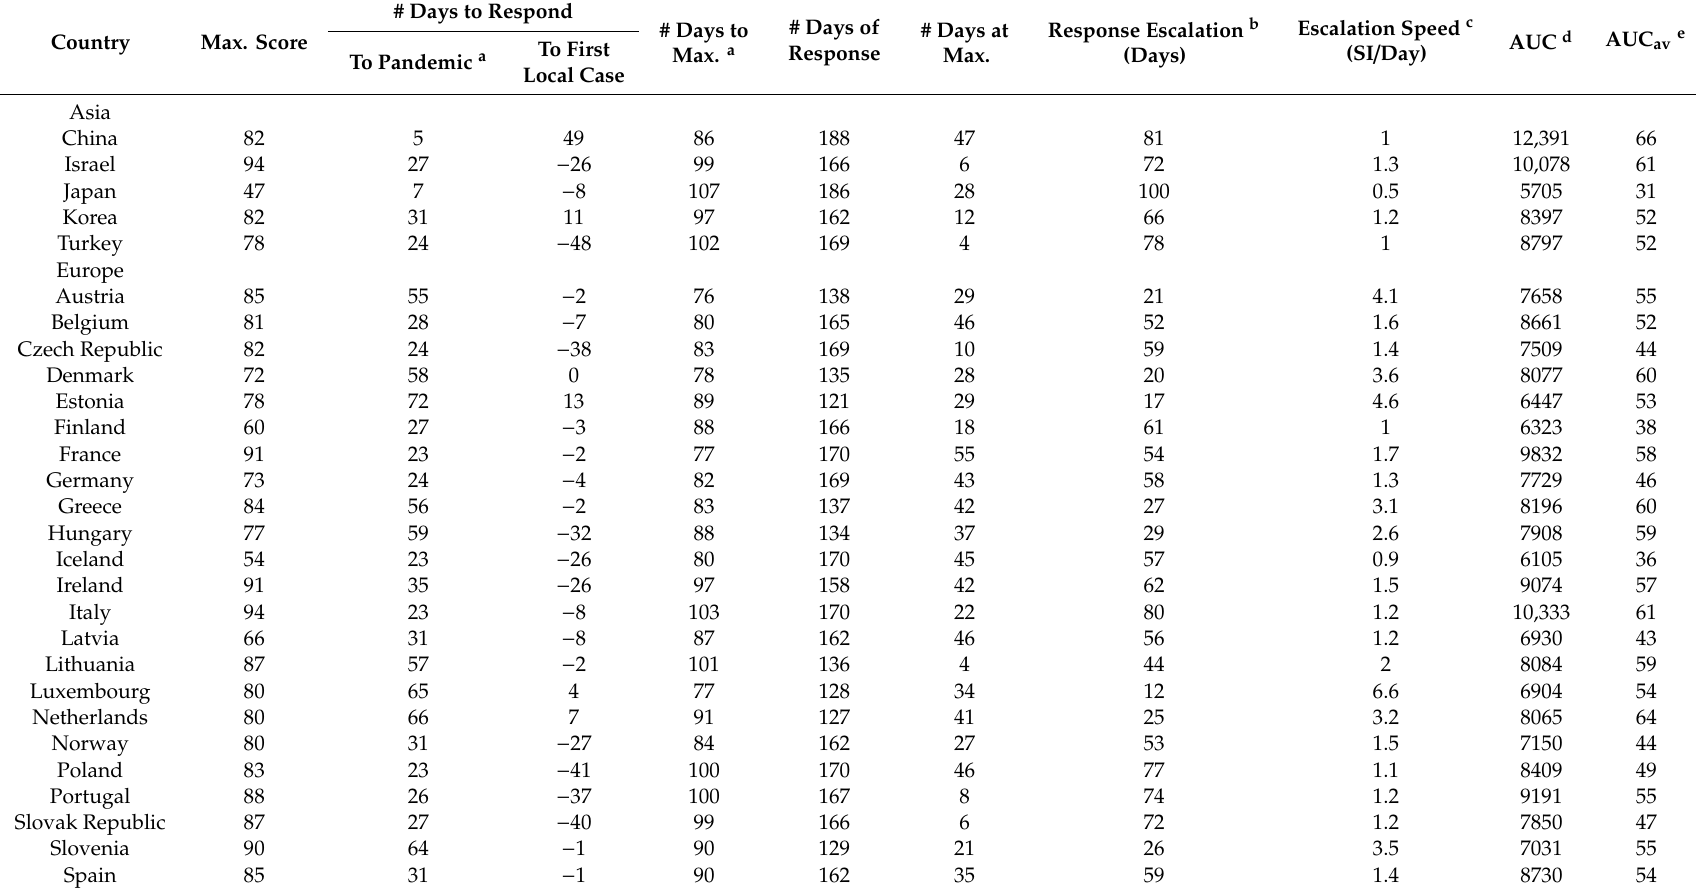
Table A1. Characteristics of Oxford Stringency Index for China and 37 OECD countries from January to July